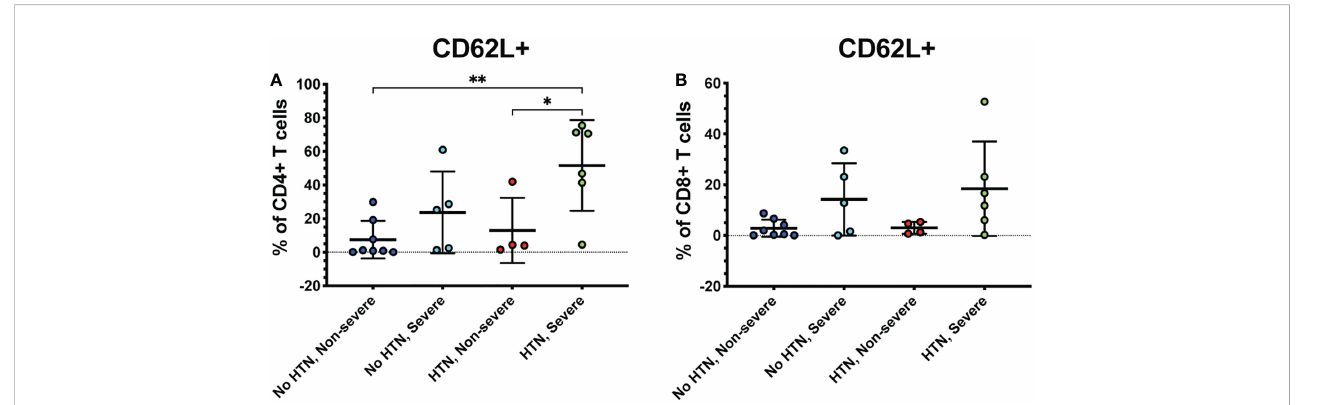
FIGURE 6 Severe COVID-19 patients with hypertension have greater frequencies of CD62L+ CD4+ T cells. The frequencies of CD4+ (A) and CD8+ T cells (viable, CD14-, CD56-, CD19-, CD3+, CD4+ or CD8+ cells) (B) expressing CD62L in severe and non-severe COVID-19 patients with or without hypertension were assessed by fl ow cytometry. *p<0.05, **p<0.01 one-way ANOVA with multiple comparisons